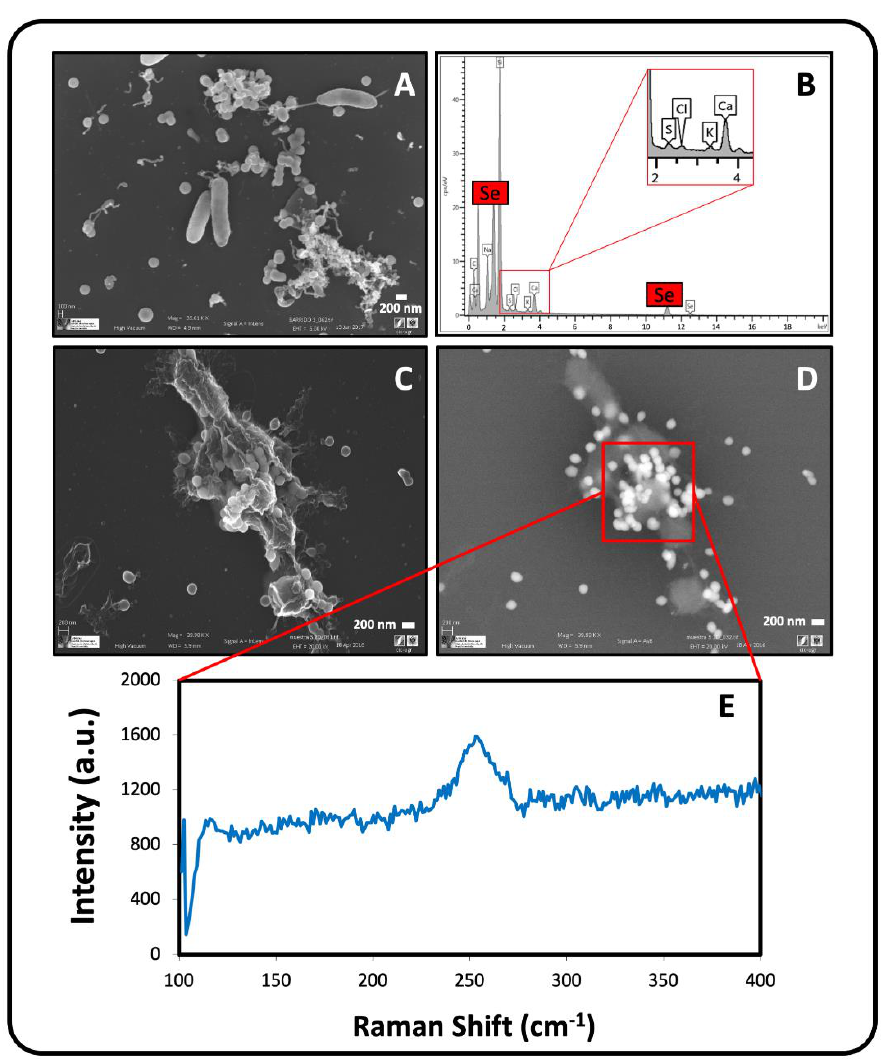
Figure 6. VP-FESEM micrographs of Se nanospheres located extracellularly, intracellularly and attached on lysed cells of S. bentonitica ( A , C , and D ) produced anaerobically at an initial pH of 10. EDX analysis showing the Se and S composition of the nanospheres ( B ). Raman analysis derived from Se nanosphere accumulations ( E ). Scale bars: 200 nm ( A , C , D ).